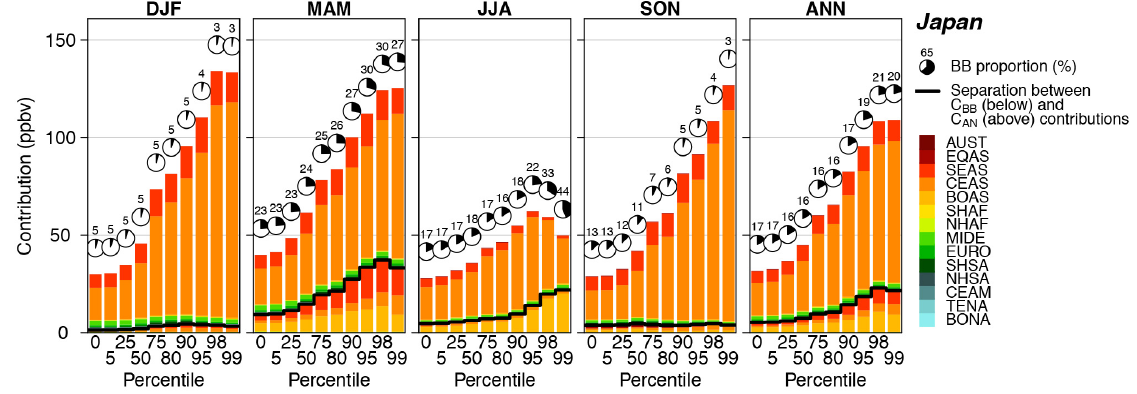
Figure 19. Same as Fig. 16 for the Japan